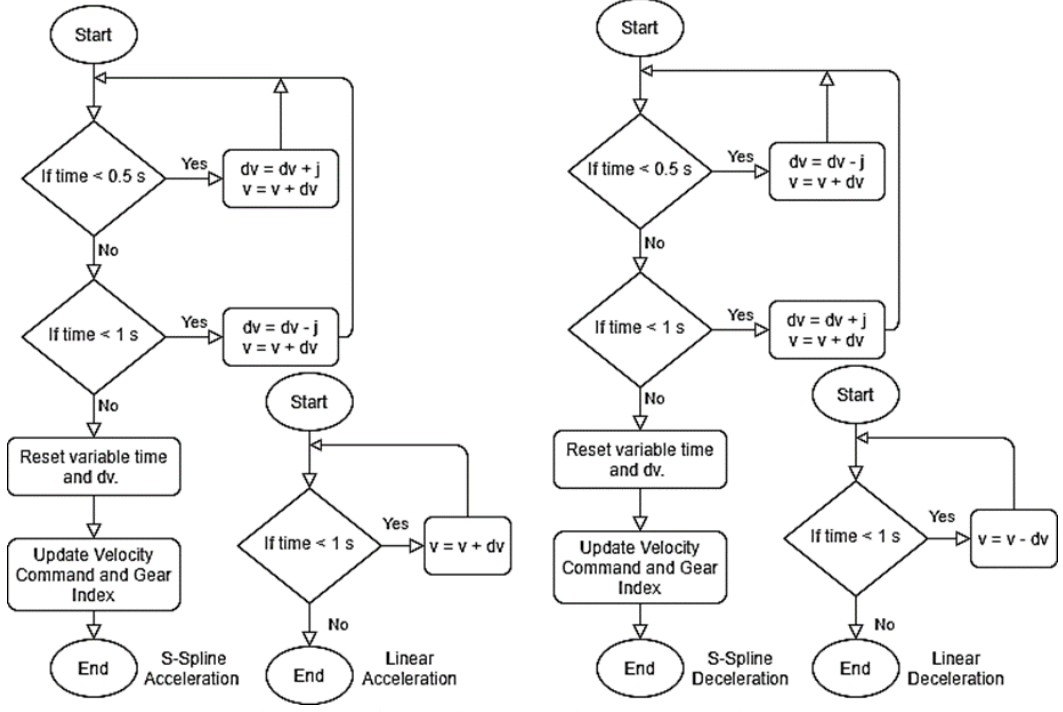
Figure 6. Flow charts for S-velocity and (linear) ramp-velocity generation.